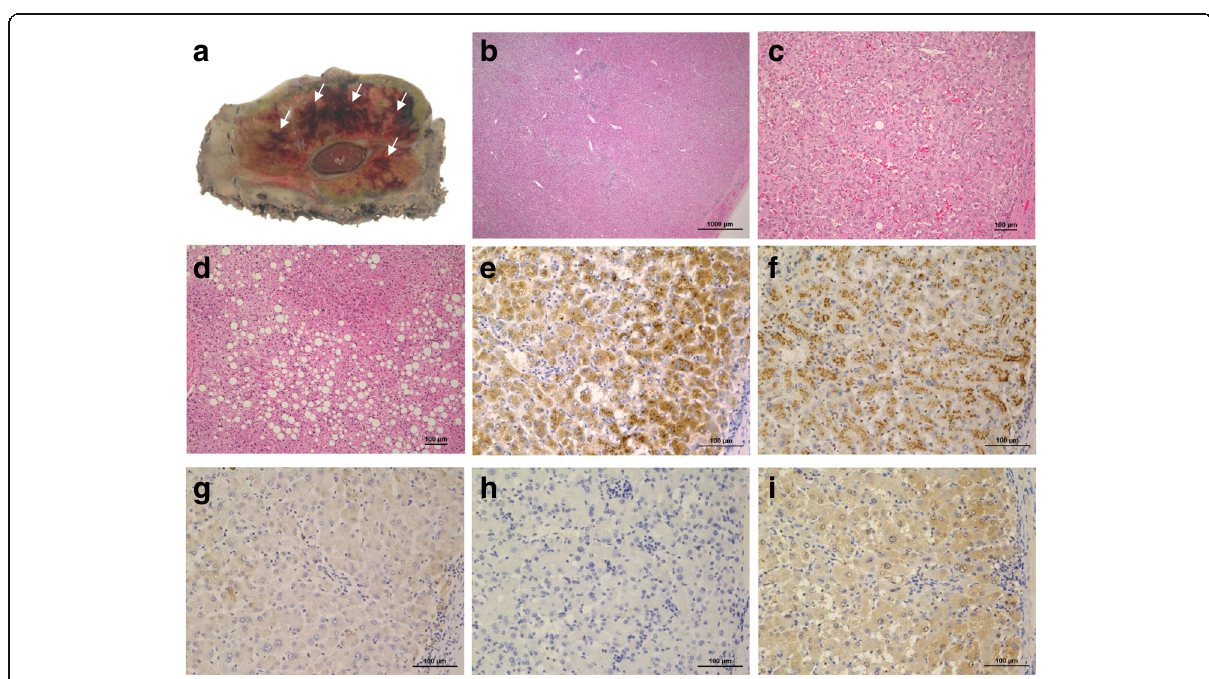
Fig. 4 Histopathological findings of the resected specimen. a Macroscopically, the tumors were yellowish and well-defined with hemorrhage (white arrows). b , c Pathological examination revealed slightly enlarged hepatocyte proliferations without nuclear atypia or mitosis. (Hematoxylin and eosin [H&E] staining, original magnification: b H&E, × 20; c H&E, × 100) d The background liver was steatotic with mild fibrosis (H&E, × 100). e – i Immunohistochemical examination revealed the following findings of the tumor cells (immunohistochemical staining, × 200): positive for serum amyloid A protein ( e ), negative for β -catenin ( f ), negative for glutamine synthetase ( g ), negative for cytokeratin 7 ( h ), and positive for fatty acid-binding protein ( i